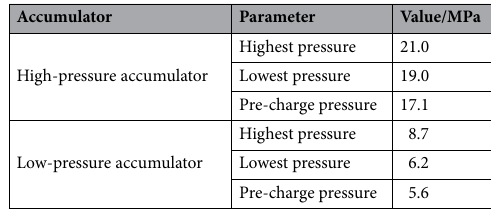
Table 3. Working pressure range of accumulators.